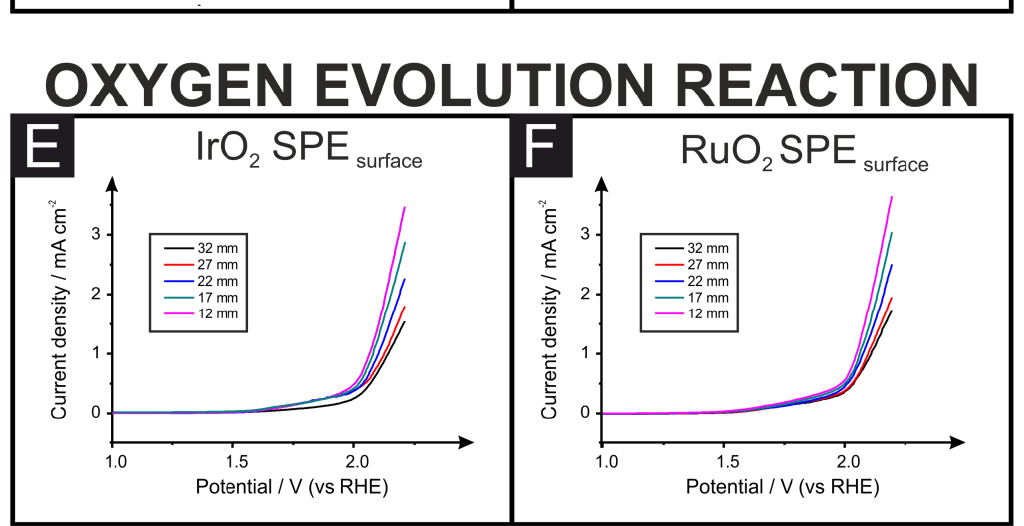
Figure 3. LSV for the different drop-casted SPEs (SPE surface ) with different connection lengths towards the HER (A) Pt/C, (B) MoS 2 , and (C) MoSe 2 ; (D) a comparison of the measured overpotential for each catalyst at different SPE connection lengths. Additionally, LSVs are shown for the drop-casted SPEs with different connection lengths towards the OER (IrO 2 (E) and RuO 2 (F) ). LSVs were recorded in 0.5 M H 2 SO 4 using a three-electrode set-up consisting of an SPE working electrode, a Pt wire counter electrode and a Ag|AgCl reference electrode.